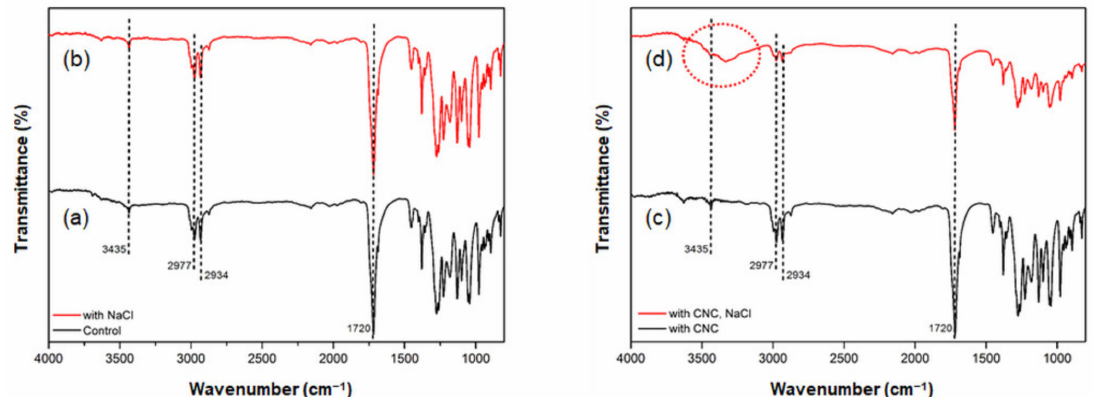
Figure 2. FTIR spectra of a PHB film obtained from C. necator incubated ( a ) without additives, ( b ) with 14.5 g/L NaCl, ( c ) with 0.1 g/L CNC, and ( d ) with 0.1 g/L CNC and 14.5 g/L